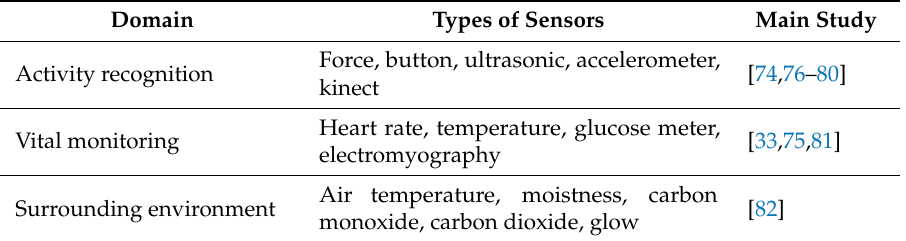
Table 6. List of ambient assisted living main domains and standard sensors that are used in each